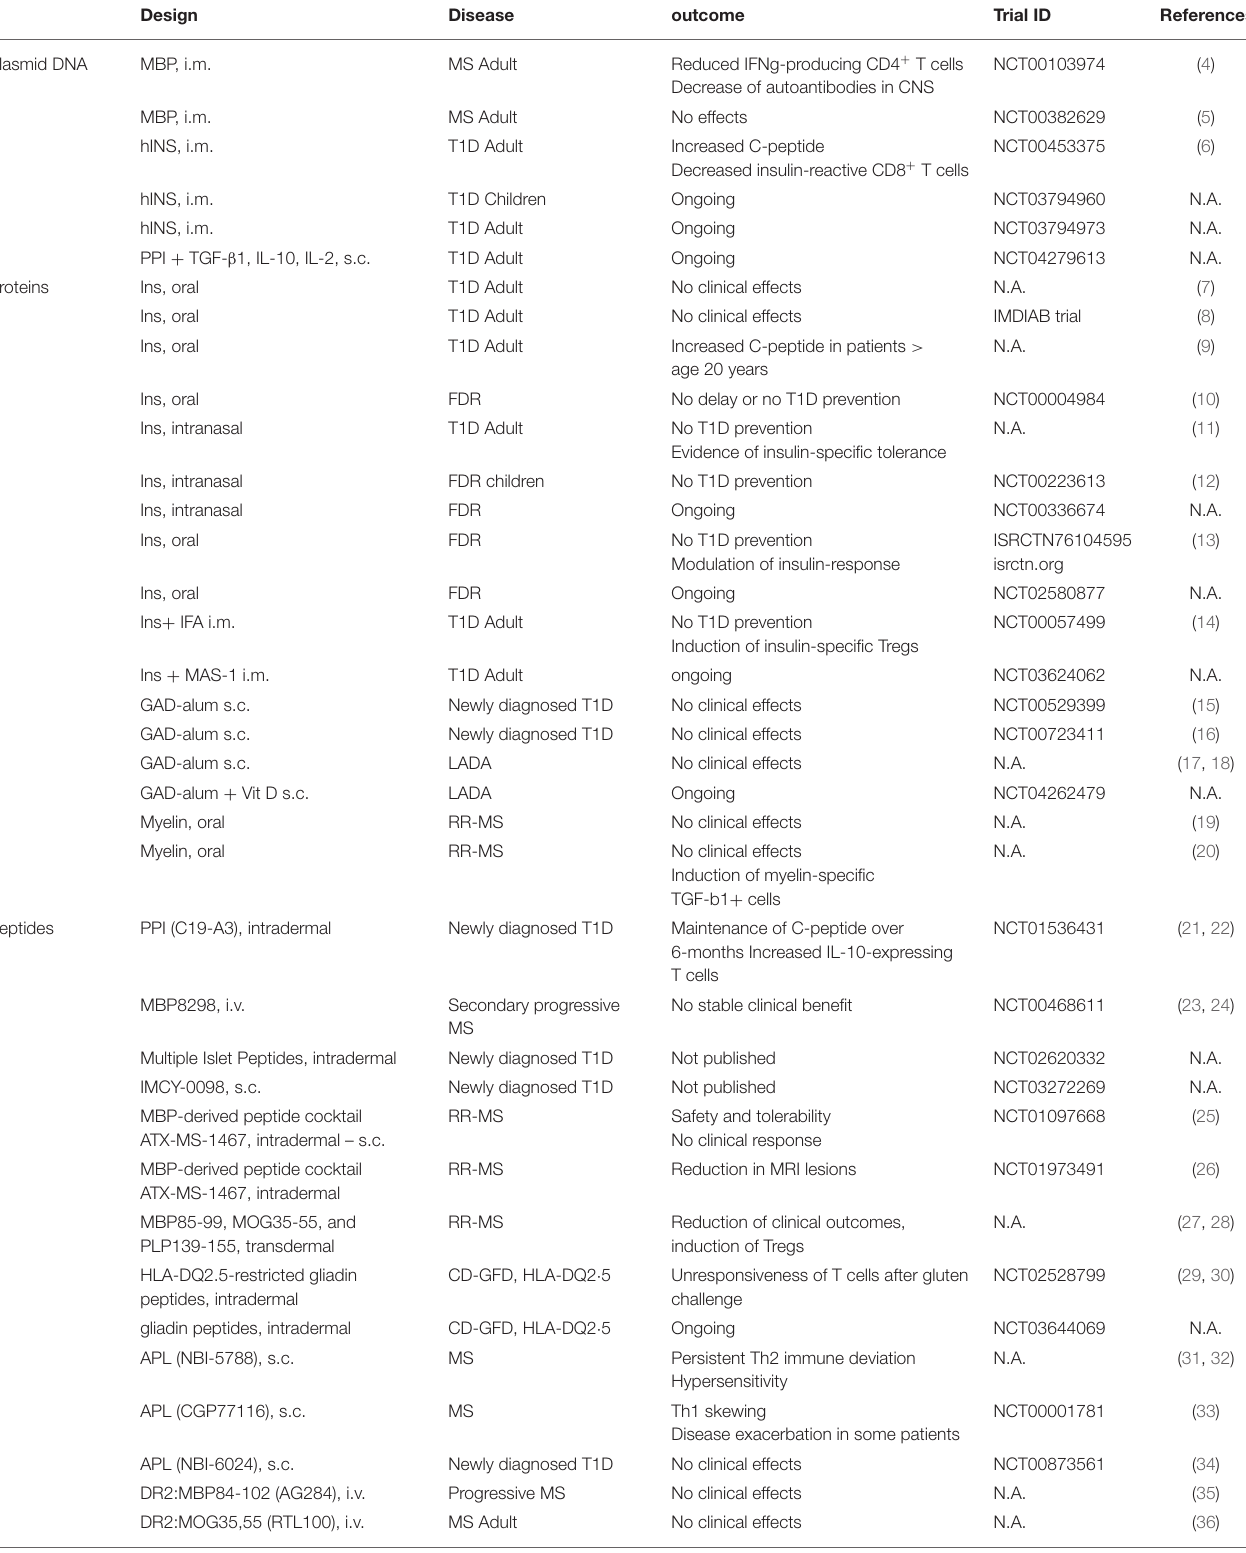
TABLE 1 | Clinical trials using antigen-specific